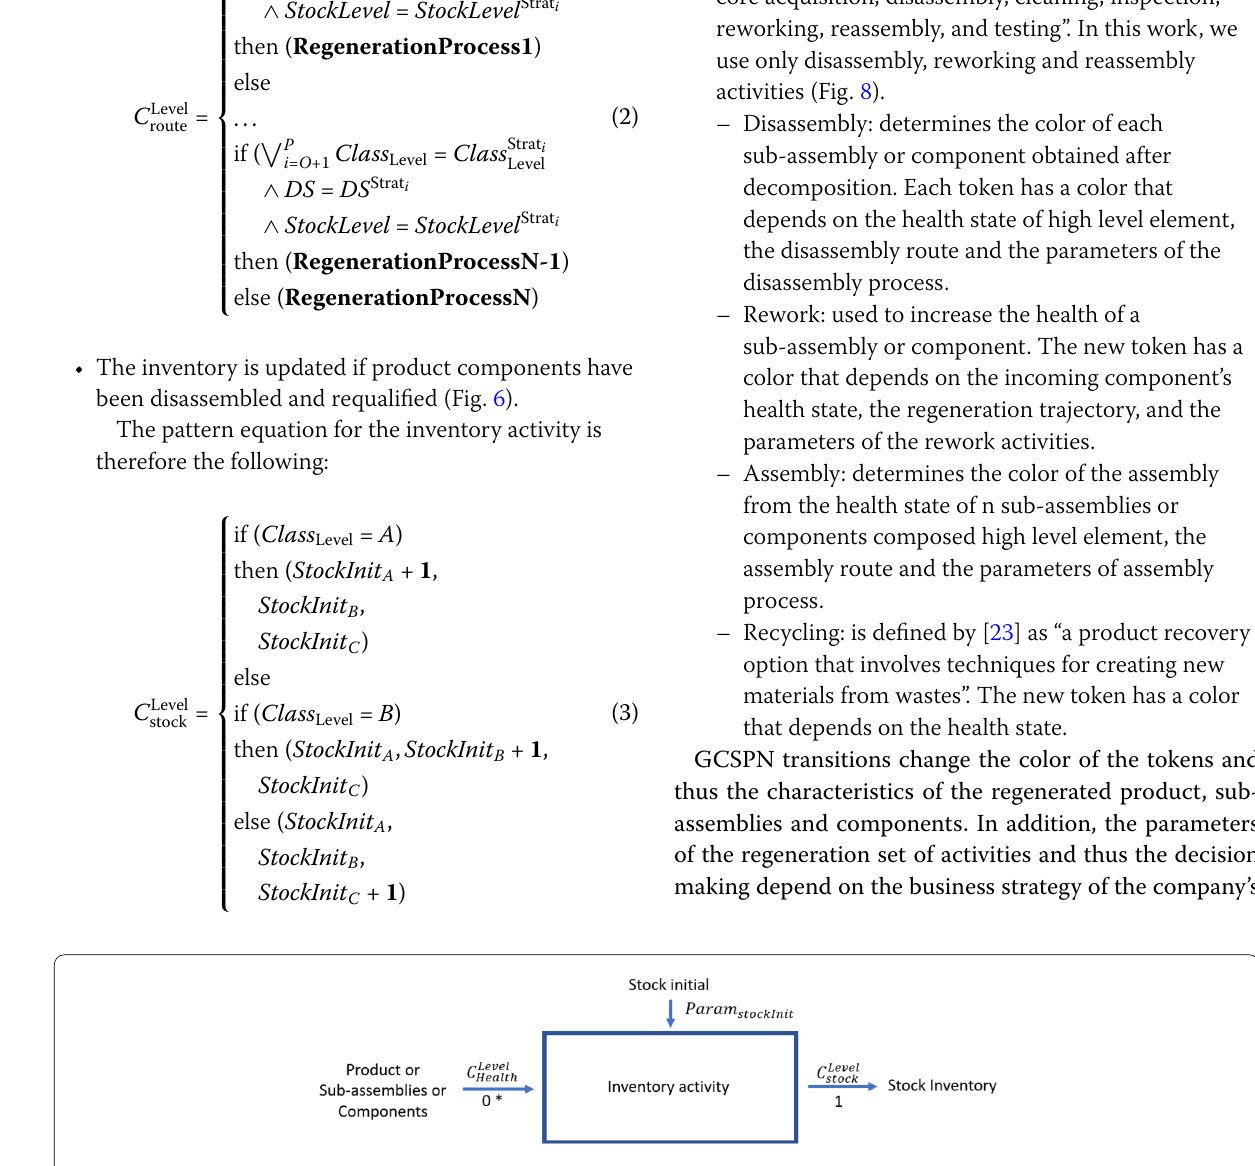
Figure 6 Input/Output of Inventory